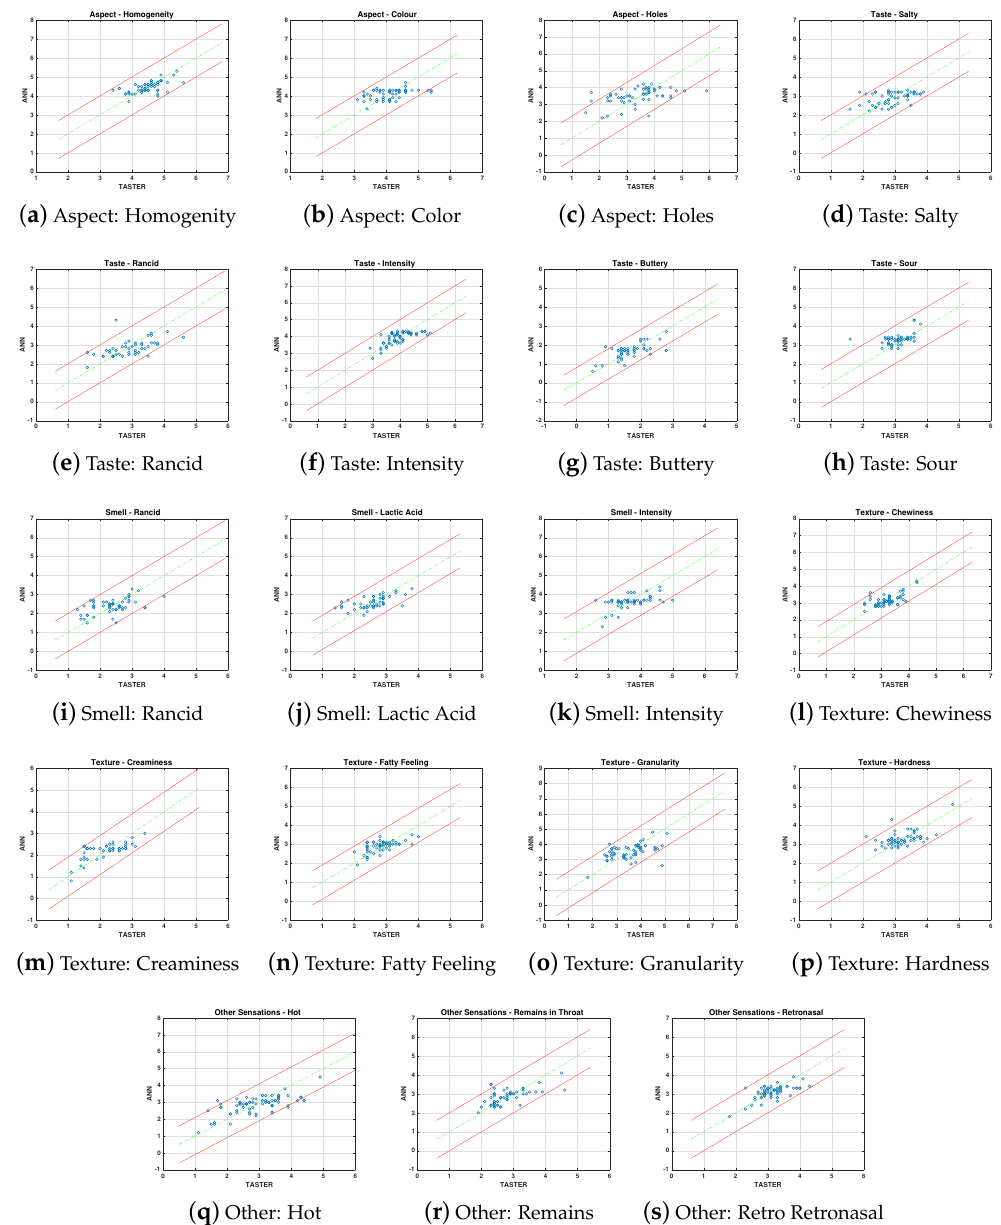
Figure 8. Scatter plot for PCA-ANN prediction results vs tasters’ scores for all sensory attributes for the prediction dataset. The performance over the attribute span is observed for the whole set of attributes in the prediction stage. The green line is the expected score and the red lines mark the interval defined with the deviation of the tasters’ scores for the total set of